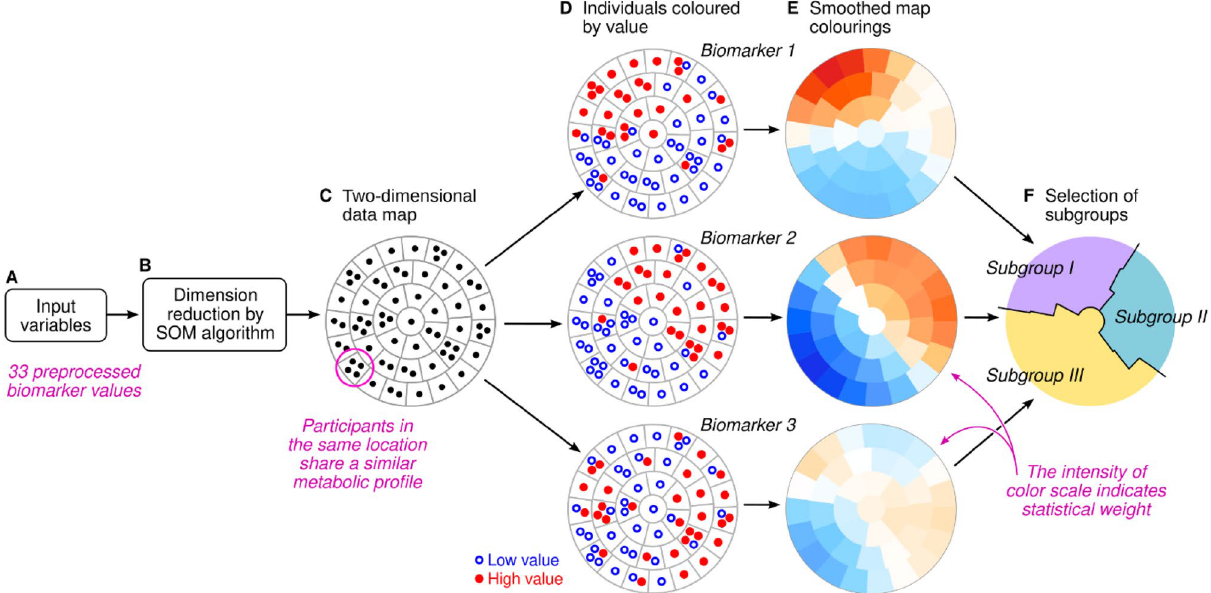
Figure 2. Schematic illustration of the subgrouping procedure. We used the self-organizing map (SOM) algorithm to project high-dimensional data onto a two-dimensional canvas that is divided into districts ( A–C ). The data points can be colored based on the observed values of any variable ( D ). In this study, the statistical weight of regional patterns was encoded in smoothed pseudo-colour representations of the observed values ( E ). The map colorings were used as visual guides to assign map districts and the participants therein into mutually exclusive subgroups ( F